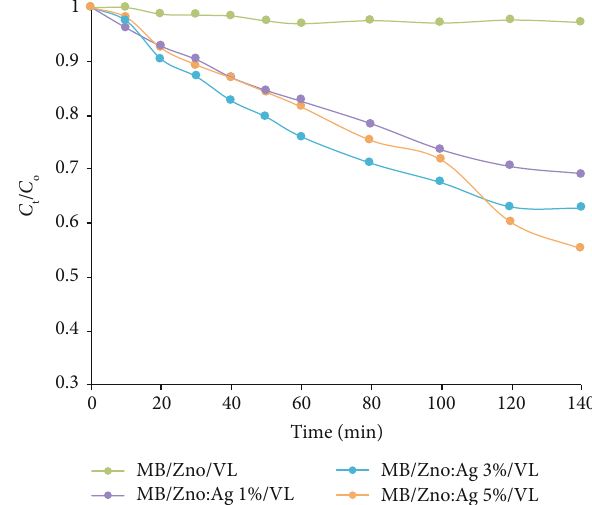
Figure 8: MB photocatalytic degradation for both ZnO and ZnO:Ag thin fi lms after 140 min under visible light (VL)